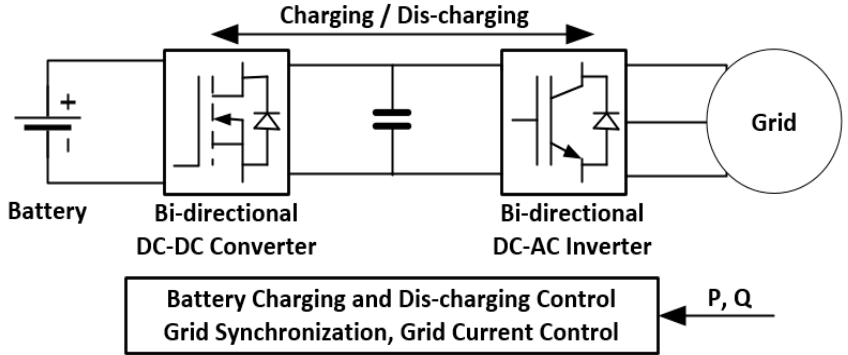
Figure 13. Bi-directional grid-connected inverter model with an ESS [16].